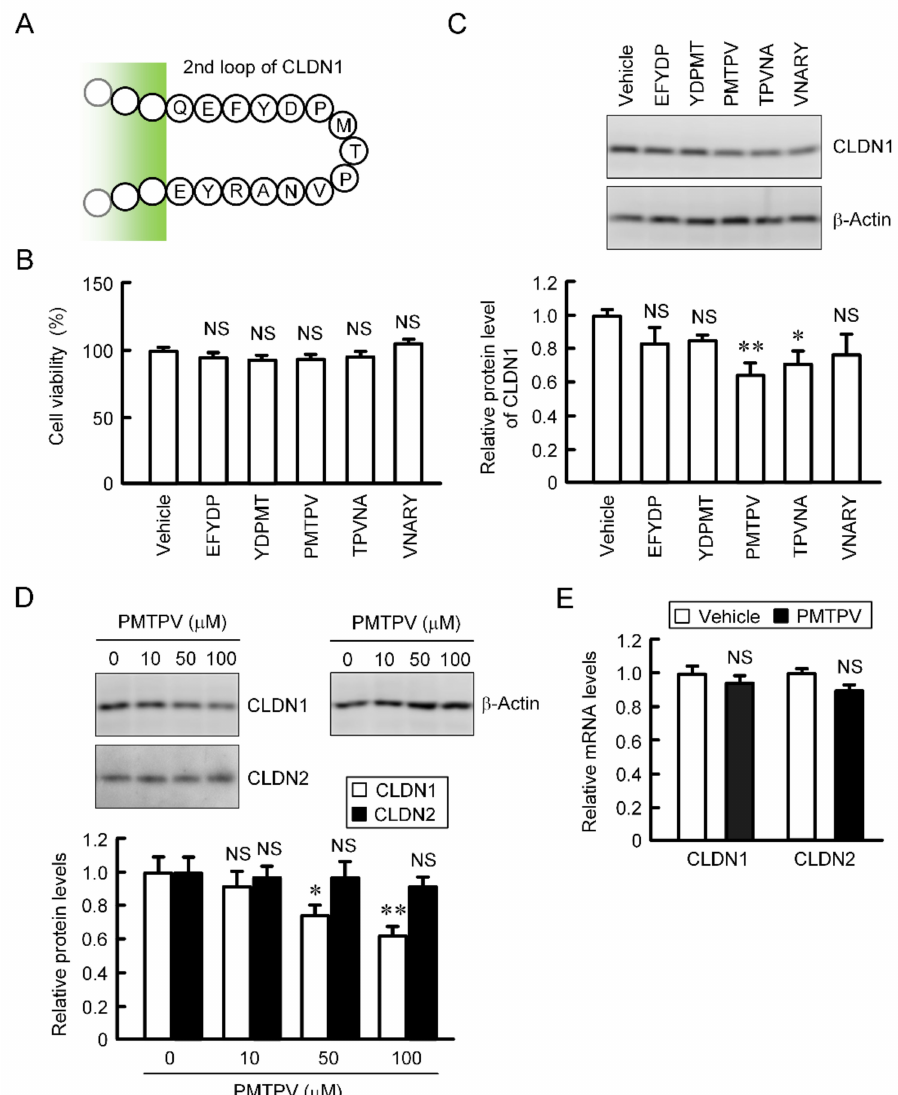
Figure 2. E ff ects of short peptides on the expression of CLDN1 in A549 cells. ( A ) Sequence of ECL2 of CLDN1. ( B ) A549 cells were incubated with each peptide at 100 µ M or without peptide (vehicle) for 24 h. Cell viability was assessed by WST-1 assay. ( C ) The cell lysates were immunoblotted with anti-CLDN1 and anti- β -actin antibodies. The protein level of CLDN1 is represented relative to the values in vehicle. ( D ) Cells were incubated with PMTPV for 24 h at the concentration indicated. The protein levels of CLDN1 and CLDN2 are represented relative to the values in 0 µ M. ( E ) Cells were incubated with PMTPV at 100 µ M for 6 h. After extraction of total RNA, quantitative real-time PCR was performed using primer pairs for CLDN1, CLDN2, and β -actin. The mRNA levels of CLDN1 (open bars) and CLDN2 (closed bars) are represented relative to the values in vehicle. n = 3–4. ** p < 0.01 and * p < 0.05 compared with vehicle or 0 µ M. NS, p >